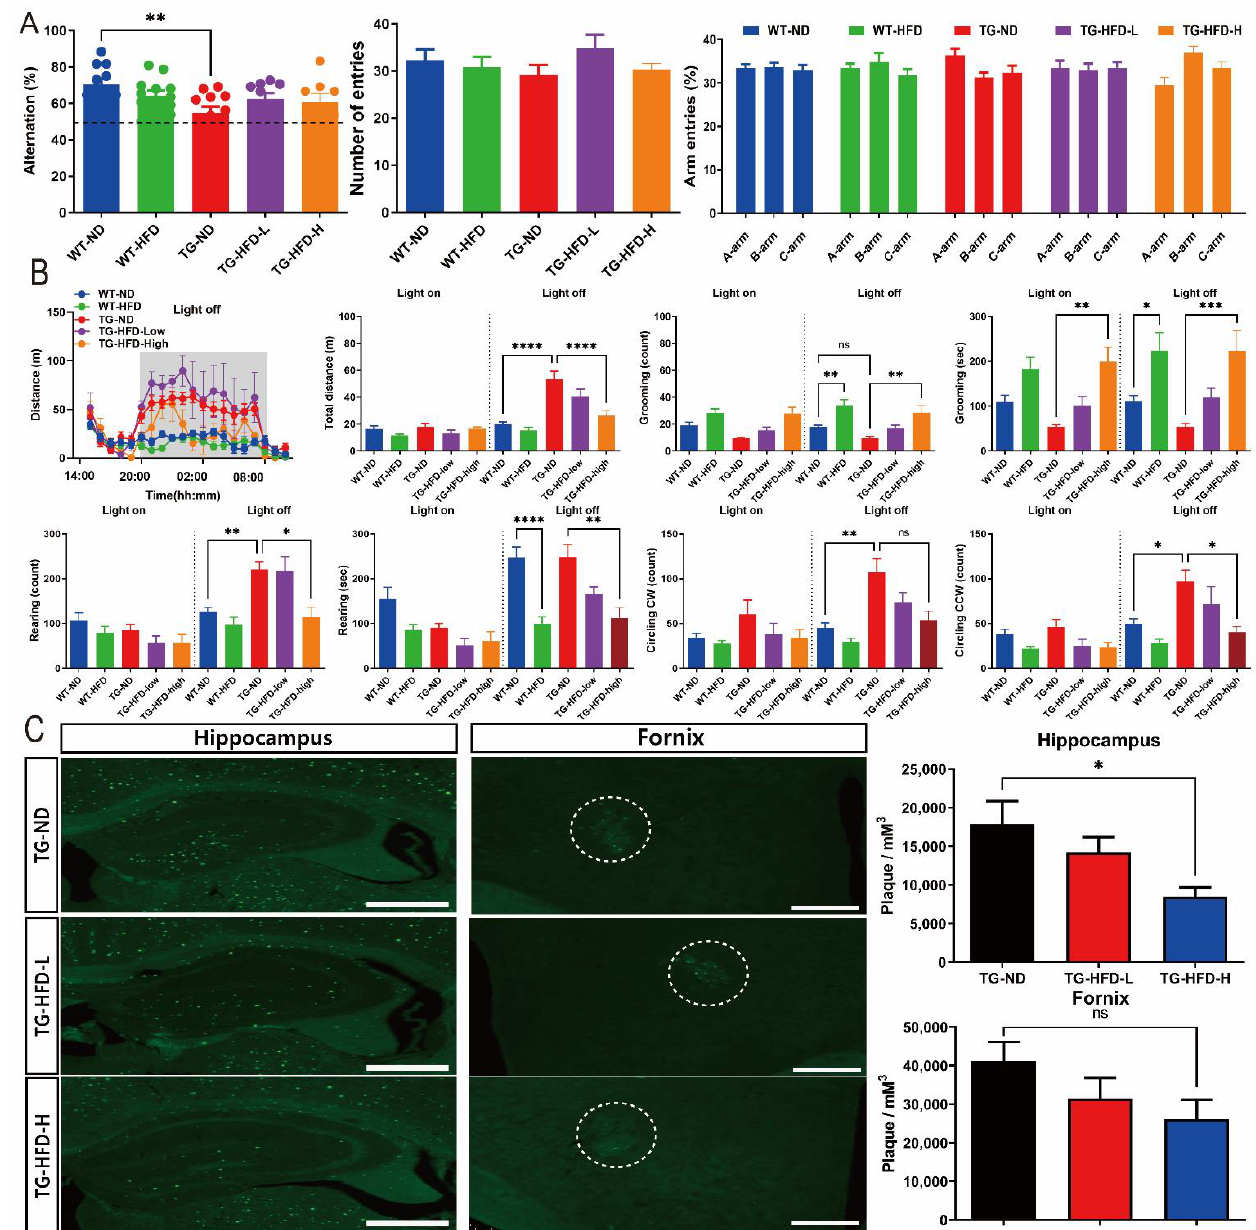
Figure 6. Investigation of behavioral changes and amyloid plaque number under a high-fat diet (HFD). Bar graphs of spontaneous alternations in the Y-maze ( A , left panel), number of entries ( A , center panel), and percent of arm entries ( A , right panel). Analysis of the general behavior of mice using the Laboratory Animal Behavior Observation, Registration and Analysis System (LABORAS) test. Total distance, duration, and frequency of grooming, rearing, and clockwise and counterclockwise circling in light-on and -off conditions ( B ). Representative images of thioflavin-S staining in the hippocampal and fornix regions ( C , left panel), bar graph of the amyloid plaque density in the hippocampal and fornix regions ( C , right panel). ns (not significant), * p < 0.05, ** p < 0.01, *** p < 0.001, and **** p < 0.0001 (one-way analysis of variance with Tukey post hoc analysis). Data are presented as the mean ± standard error of the mean. The number of mice in each group was 8 – 12 for the Y-maze, 6 – 12 for the LABORAS test, and 5 for thioflavin-S staining. ND, normal chow; WT, wildtype; TG transgenic.